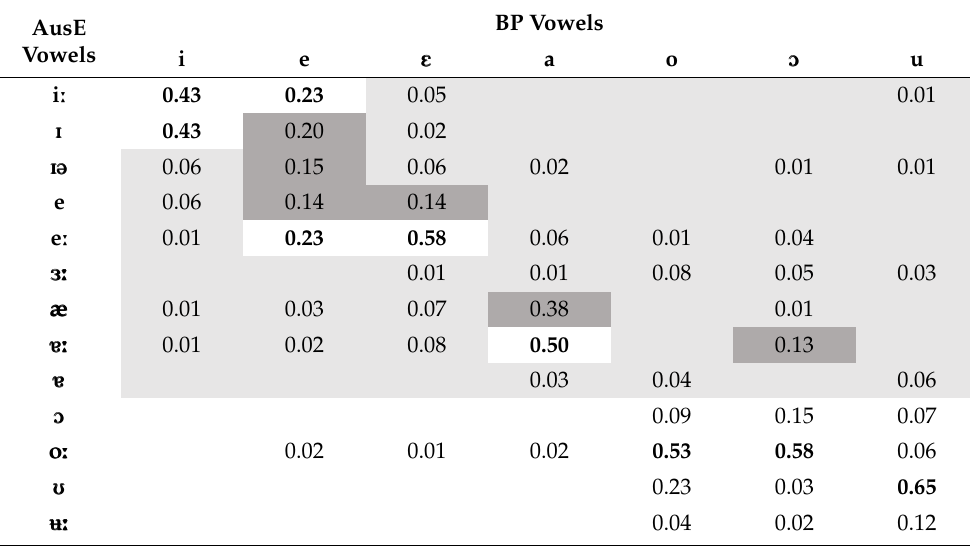
Table 4. Australian English listeners’ classification percentages. The native vowel category with the highest classification percentage appears in bold, classification percentages above chance appear in cells shaded dark grey and classification percentages below chance (i.e., 0.08) appear in cells shaded light grey.